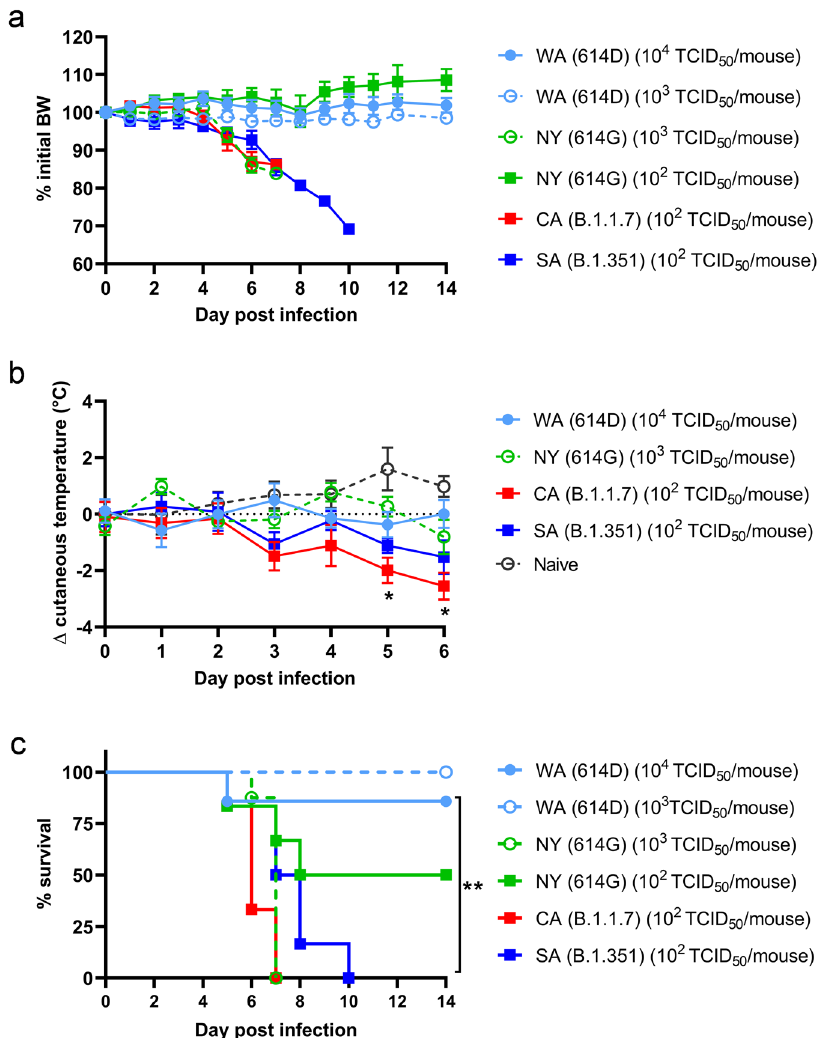
Fig. 1 Morbidity, cutaneous temperature, and mortality of K18-hACE2 mice after infections of SARS-CoV-2 and variants. K18-hACE2 mice of both sexes (~1:1 ratio) were infected intranasally with USA-WA1/2020 (WA) of lineage A bearing 614D, New York-PV09158/2020 (NY) of lineage B.1.3 bearing 614G, USA/CA_CDC_5574/2020 (CA) of lineage B.1.1.7 or hCoV-19/South Africa/KRISP-EC-K005321/2020 (SA) of lineage B.1.351 at indicated doses in an ABSL-3 biocontainment. Data are expressed as mean ± s.e.m of 6 – 8 mice/group (WA (614D) (10 3 TCID 50 /mouse): n = 8 mice/group; WA (614D) (10 4 TCID 50 /mouse): n = 7 mice/group; NY (614G) (10 2 TCID 50 /mouse): n = 6 mice/group; NY (614G) (10 3 TCID 50 /mouse): n = 8 mice/group; CA (B.1.1.7) (10 2 TCID 50 /mouse): n = 6 mice/group; SA (B.1.351) (10 2 TCID 50 /mouse): n = 6 mice/group; naïve: n = 4 mice/group). * p < 0.05 and ** p < 0.01 by two-way mixed ANOVA (cutaneous temperature change) or by Log-rank (Mantel-Cox) test (survival curves). ( a ) Body weight (BW); ( b ) cutaneous temperature change; ( c )